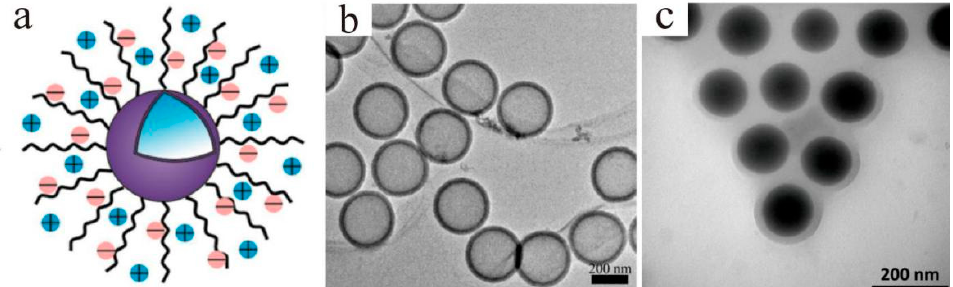
Figure 15. ( a ) Schematic and ( b ) TEM representation of PSPMA-g-HSNPs [89]. Reproduced with permission from [Guoqiang Liu et al.], [The Journal of Physical Chemistry B]; published by [American Chemical Society], 2014. ( c ) TEM image of PMMA brush-g-SiO 2 [91]. Reproduced with permission from [Amir Beheshti et al.], [Tribology International]; published by [Elsevier],